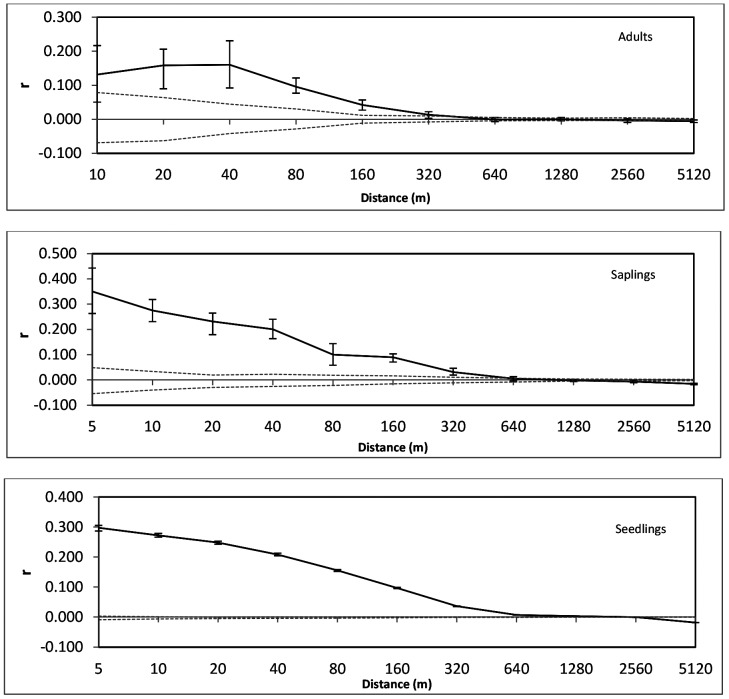
Spatial genetic structure autocorrelograms for adults, saplings, and seedlings, respectively.‘r’ is the relatedness coefficient of Queller & Goodnight [45] as implemented in GenAlex. Error bars are 95% confidence intervals for the value of r. Upper and lower bounds (dashed lines) represent the 95% confidence intervals for the null hypothesis (no spatial structure).